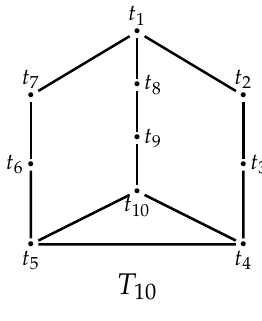
Figure 1. Two well-covered graphs with no 4 or 5